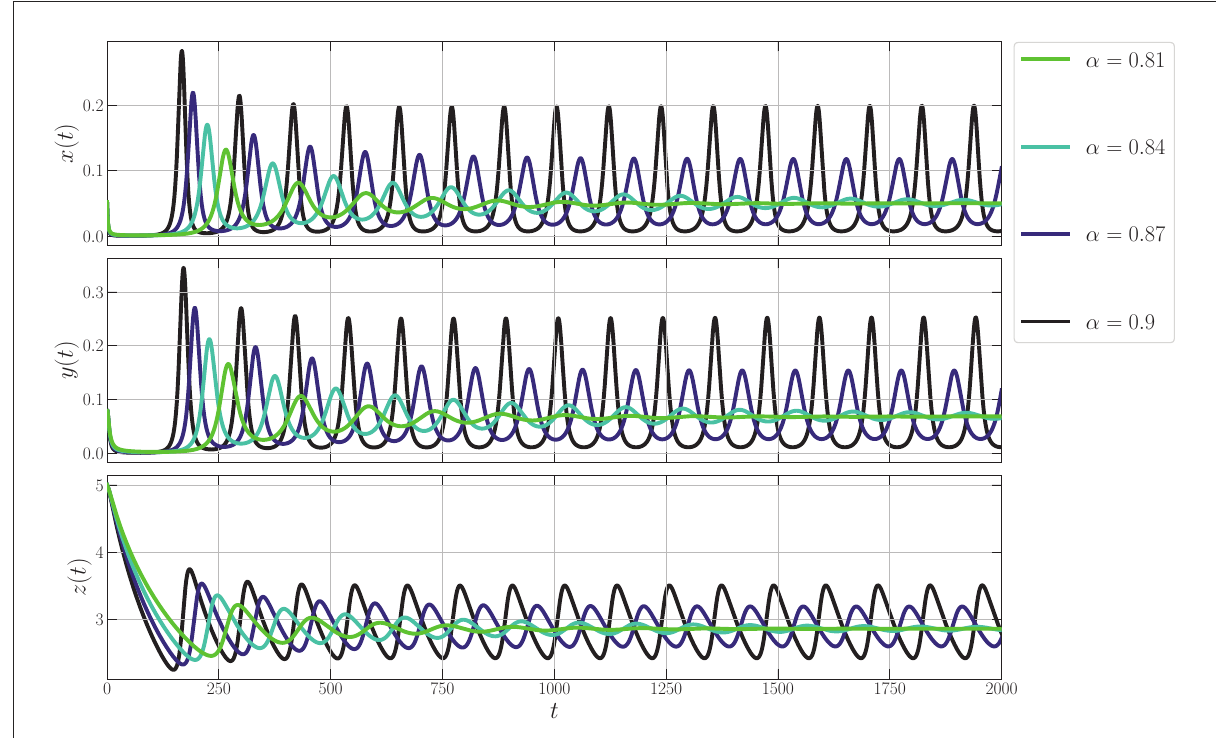
FIGURE7 Phase portrait of the model (Equation 3) around interior point E I using parameter values from Equation